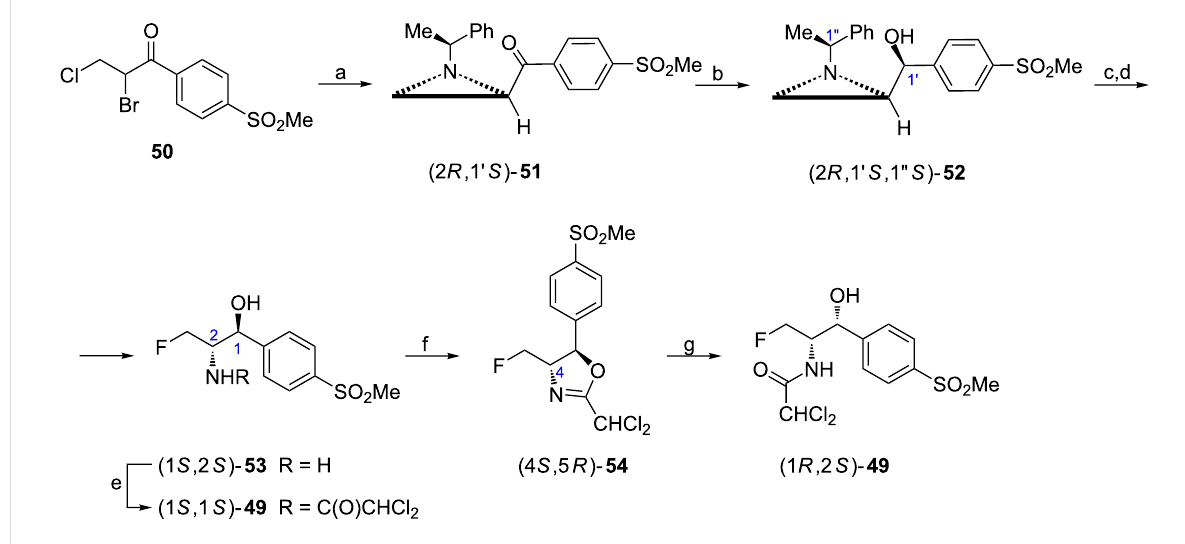
Scheme 15: Synthesis of florfenicol ((1 R ,2 S )- 49 ). Reagents and conditions: a) ( S )-1-phenylethylamine, TEA, MeOH, rt, 3 h then crystallization; b) NaBH